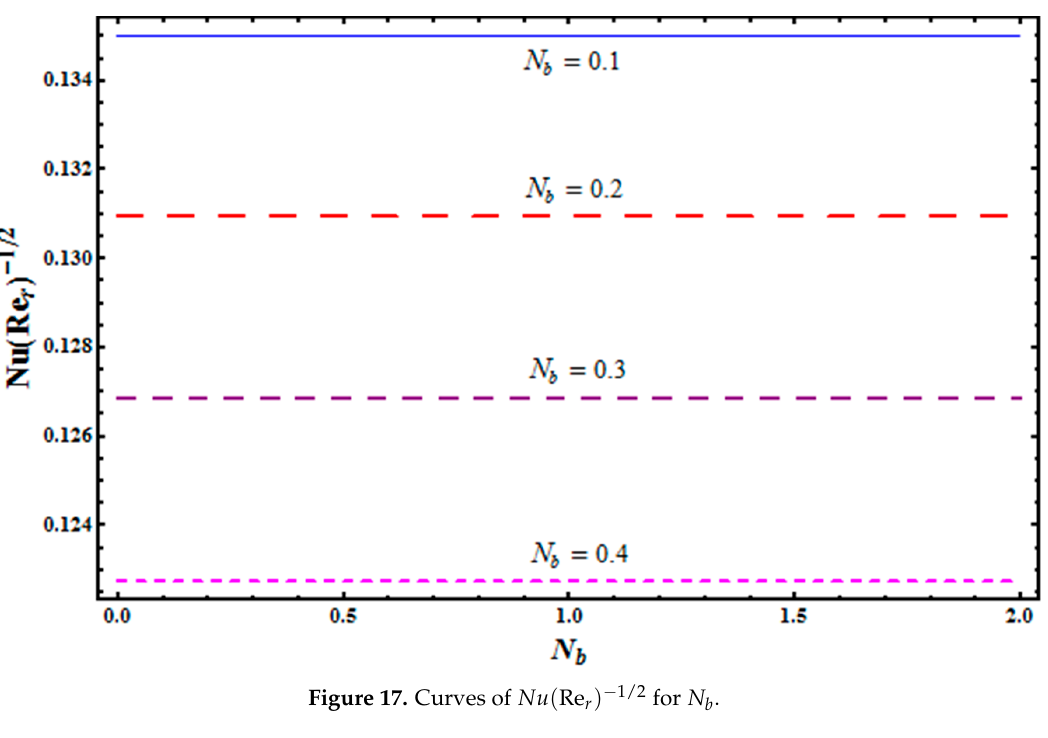
Figure 17. Curves of Nu ( Re r ) − 1/2 for N b .